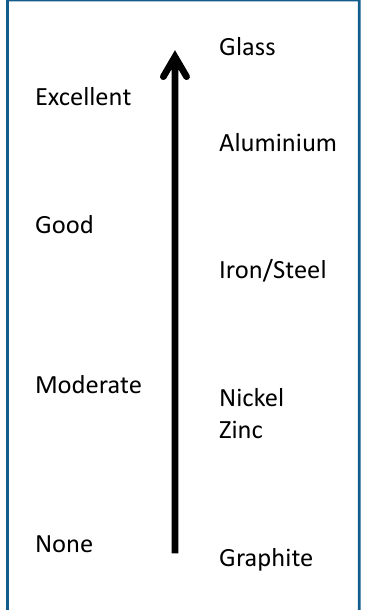
Figure 4. Schematic illustration of the effectiveness adhesion of silane-based adhesives and sealants (AS) on different substrates. Adapted from [24].